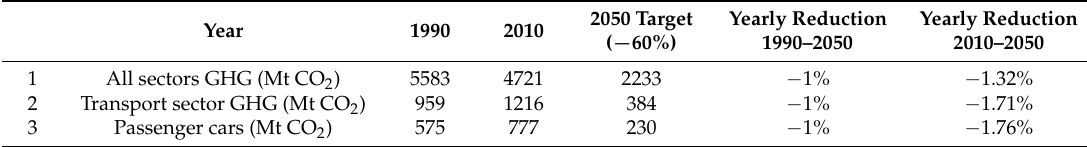
Table 1. Emission targets using 1990 and 2010 values. Source: